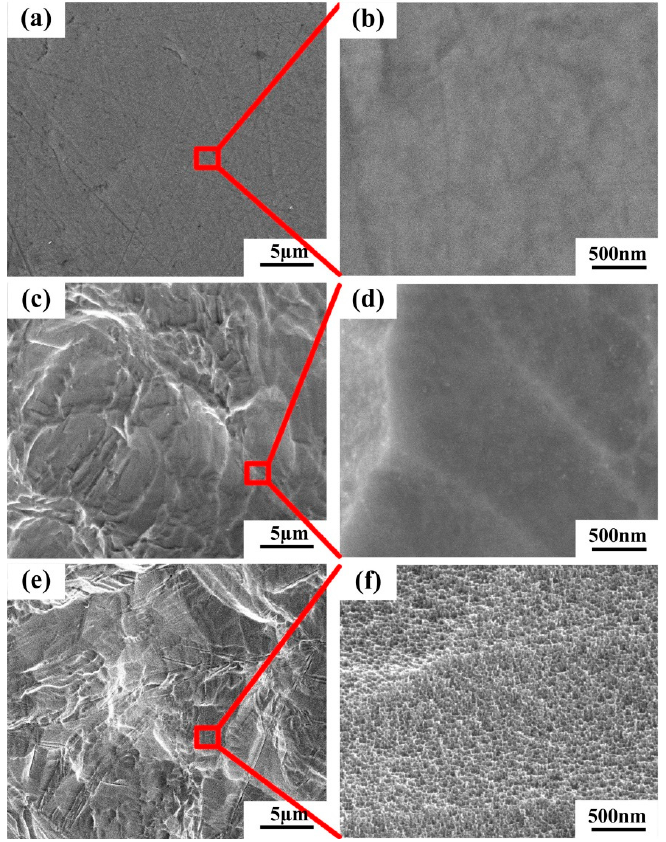
Figure 2. SEM images of ( a , b ) P-Ti, ( c , d ) M-Ti, and ( e , f ) MN-Ti.